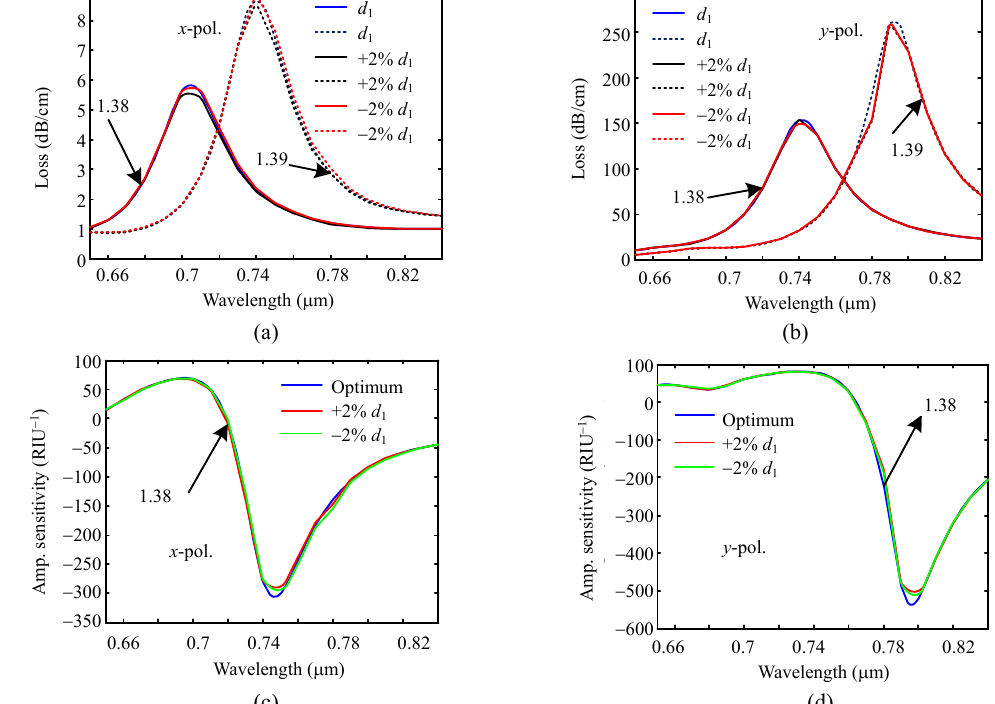
Fig. 9 Loss spectra as a function of wavelength for: (a) x- and (b) y -polarized modes, amplitude sensitivity as a function of wavelength for (c) x- and (d) y -polarized modes while d 1 is changed by ±